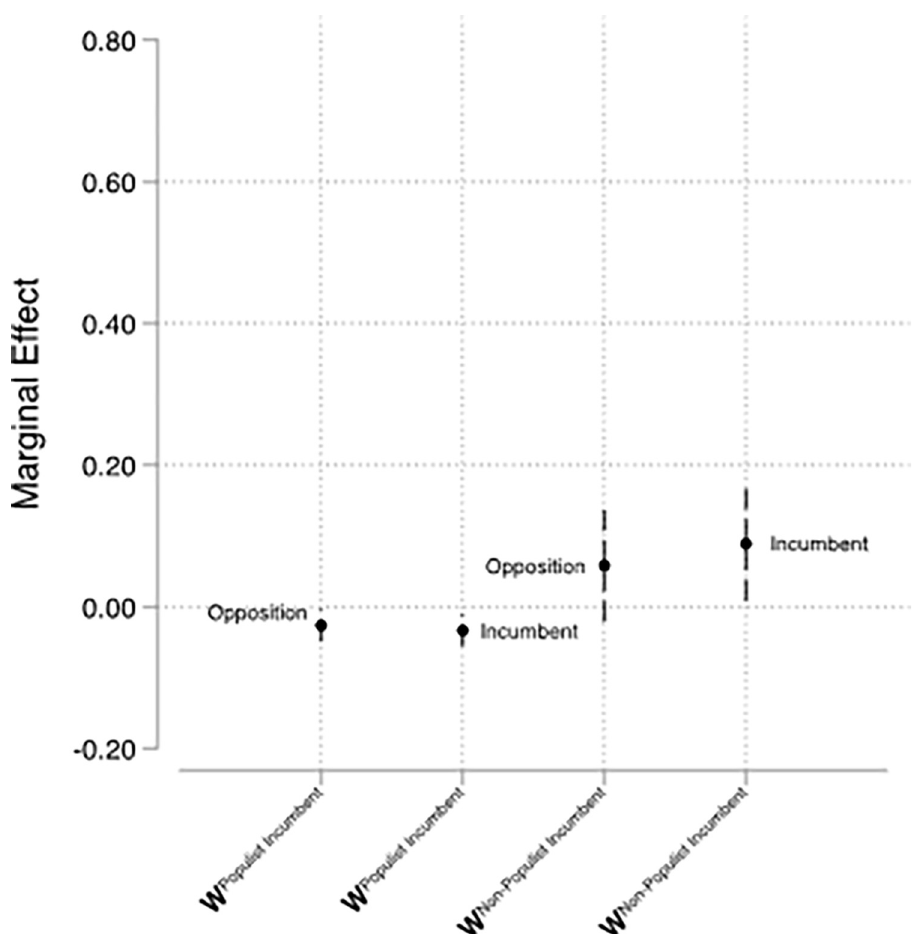
Fig 1. Short-term effects. Notes . Point estimates pertain to average marginal effects. Dashed lines signify 95 percent confidence intervals. Estimates based on Model